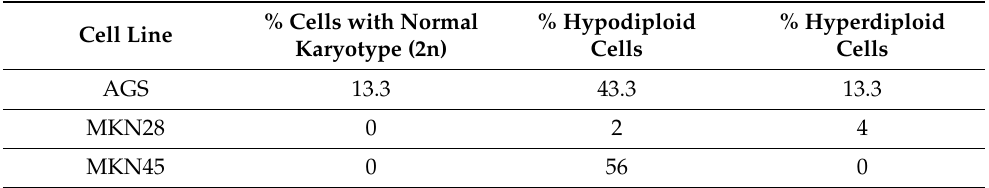
Table 2. Percentage of normal and aneuploid present in AGS (passage 49), MKN28 (passage 16), and MKN45 (passage 4) cell